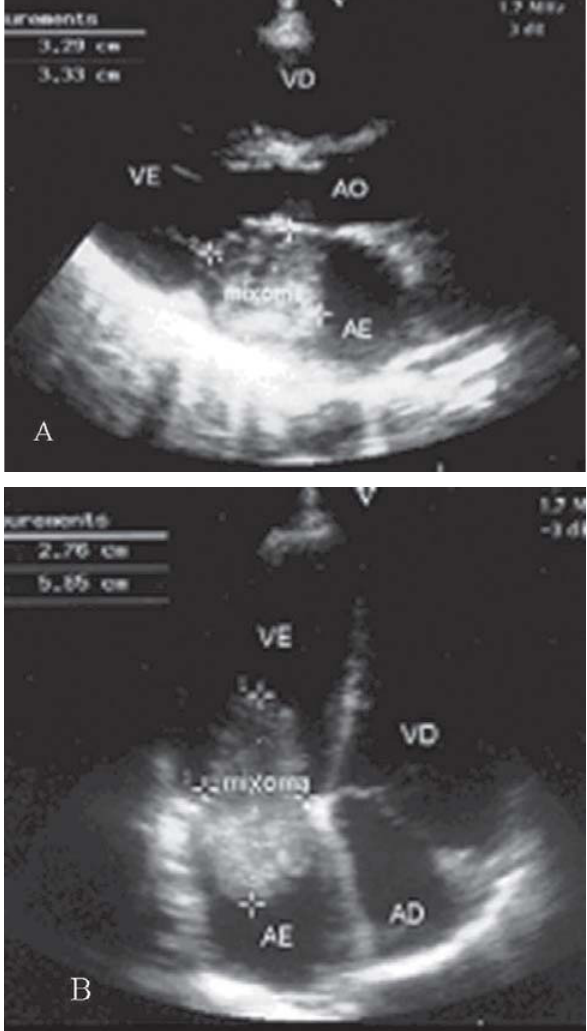
Fig. 1 - Ecocardiograma transtorácico. A- Sístole ventricular. B- Prolapso da tumoração atrial através da valva mitral, para o interior do ventrículo esquerdo, durante a diástole